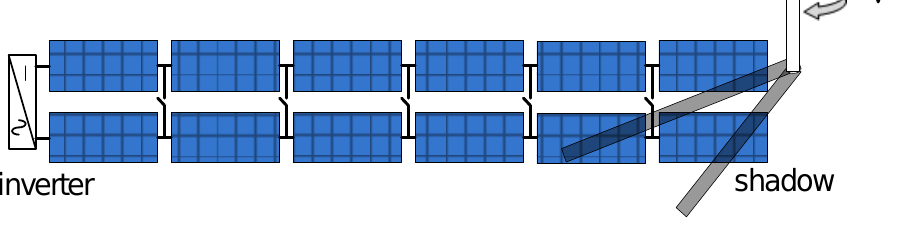
Figure 5. Probable shadow projections in the studied situation.